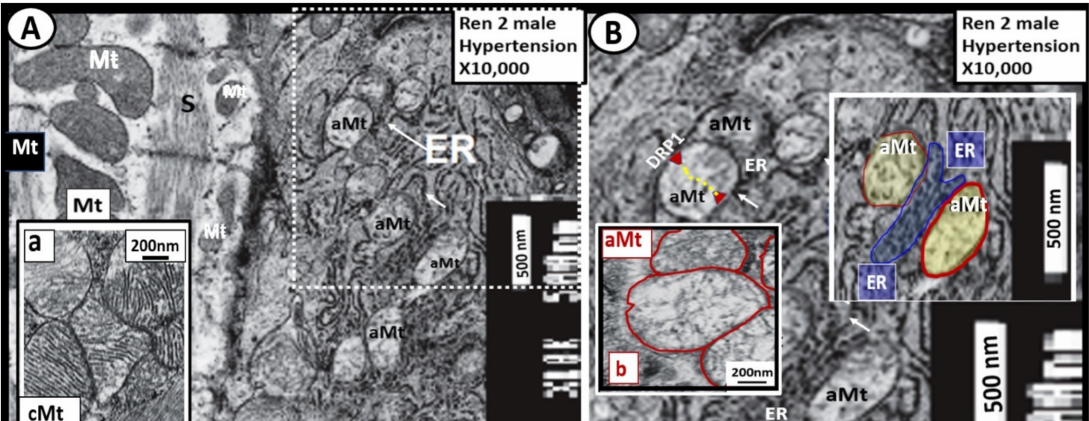
Figure 8. The close ultrastructural relationship between the myocardial mitochondria (Mt) and the endoplasmic reticulum (ER) in the hypertensive 7-week-old male Ren2 model with insulin resistance and impaired glucose tolerance. Panel A demonstrates that cardiomyocyte Mt are actually in very close contact with the ER (arrows), which would enable considerable crosstalk in the white dashed boxed-in region. Importantly, note the normal electron-dense Mt in the far left-hand side of this image and insert ( a ) and compare them to the aberrant Mt (aMt) (electron hyperlucent Mt with loss of crista) in panel B . Panel B depicts a higher magnified exploded view from the dashed boxed-in region of panel A. Note the extremely electron-dense membranes of the endoplasmic reticulum (ER) and how the outer membranes of the ER appear to be touching and possibly communicating with the outer membranes of the aberrant Mt (aMt) termed mitochondria-associated membrane(s) or (MAMs). Further, note that the aMt (outlined in red) are in close proximity and apposition with the ER membranes (pseudo-colored blue). This indicates, at the very least, an ultrastructural potential for ER-Mt crosstalk due to MAMs. There is close proximity of less than 100 nm to the actual contact between the outer membranes of the aMt and the ER. This close apposition and touching of the MAMs may allow for considerable crosstalk between the ER and Mt and thus allow for calcium and reactive oxygen species transfer, which may increase ER stress when there is Mt dysfunction due to aMt since the ER utilizes ATP from the Mt. Importantly, impaired Mt fission and mitophagy machinery in concert with ER stress may result in cellular apoptosis. This close apposition/touching allows MAMs to be responsible for (1) calcium buffering; (2) Mt fission; (3) phospholipid exchange. Importantly, the longer these aberrant Mt are not ‘taken-out’ or removed by mitophagy the greater the possibility for reactive oxygen species (mt ROS) and calcium to leak and cause further generation of reactive oxygen, nitrogen, and sulfur species to active the reactive species RONSS interactome and cardiomyocyte dysfunction and Mt leakage of cytochrome c to induce myocardial cellular apoptosis. While this image is from the Ren2 hypertensive myocardium experiment [27], this close association between the ER and aMt is known to be present in other organs in multiple different disease states. Original magnification = × 10,000; scale bars = 500 nm. DRP1 = dynamin-related protein 1